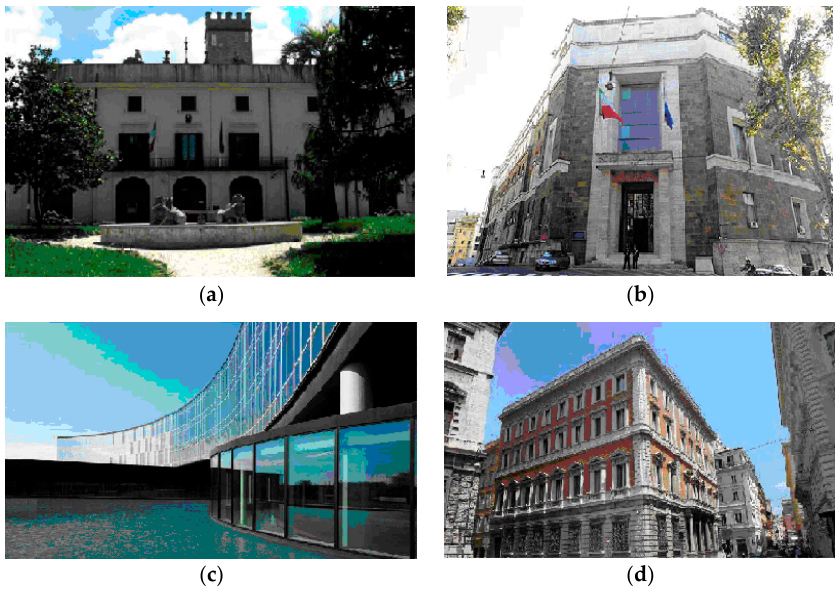
Figure 1. The four analyzed public buildings: ( a ) Villa Sciarra and ( b ) Italian Ministry of Economic Development (MiSE) facades; ( c ) Italian Space Agency (ASI) and ( d ) Ex Banco Napoli Building facades.